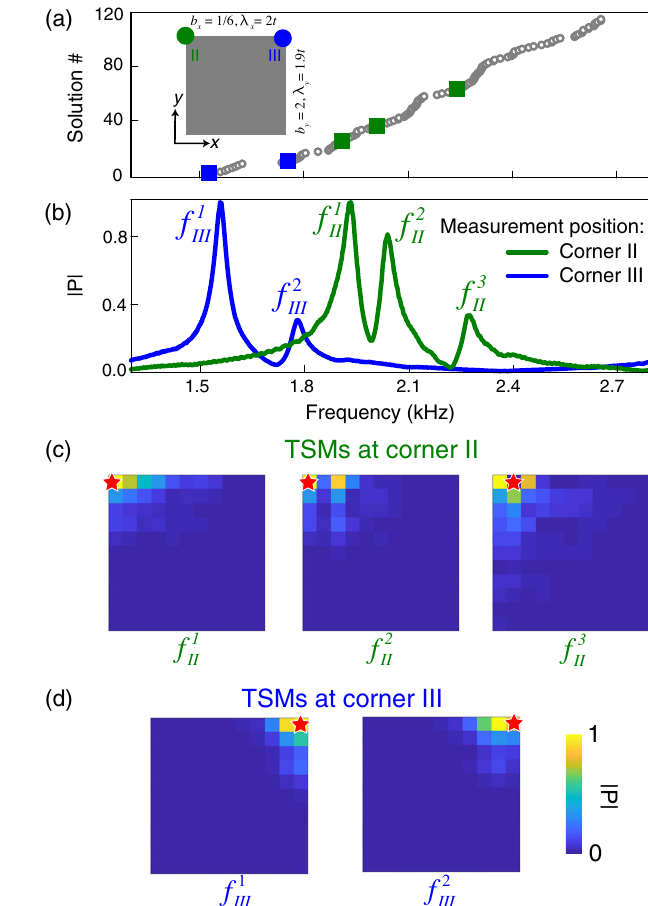
FIG. 5. Using TSM to realize BIC in real space. (a) The FIG. 6. Exploiting the TSMs for the realization of multiple pressure responses measured at corner III (red) and in the bulk ¼ 2060 Hz is seen for the TCMs at the same corner. (a) Eigenspectrum of a 4D acoustic (gray region). A single peak at f BIC system with b x ¼ 1 = 6 ; b y ¼ 1 = 3 at ð ϕ x ; ϕ y Þ ¼ ð − 0 . 6 π ; − 0 . 28 π Þ . corner response, which overlaps with the second bulk band. (b) The spatial field map at f (b) The measured corner responses have three peaks for corner II when the source is at corner III. BIC (green) and two peaks for corner III (blue). The peak frequencies A highly localized corner mode is seen. (c) Excited at f by a BIC are consistent with the eigenfrequencies found in finite-element source at the center, extended modes occupying the entire bulk simulation. (c) and (d) are field maps of the three TSMs at corner are seen. (d) In comparison, when the system is pumped at f BIC II and the two TSMs at corner III, respectively. The red stars mark by a source placed at corner I, the field map indicates extended the source position in each case. Note that the third TSM at corner modes. The inset in (a) is a schematic drawing of the 2D acoustic II is excited with a source located one site away from the lattice with the corners are color tagged.